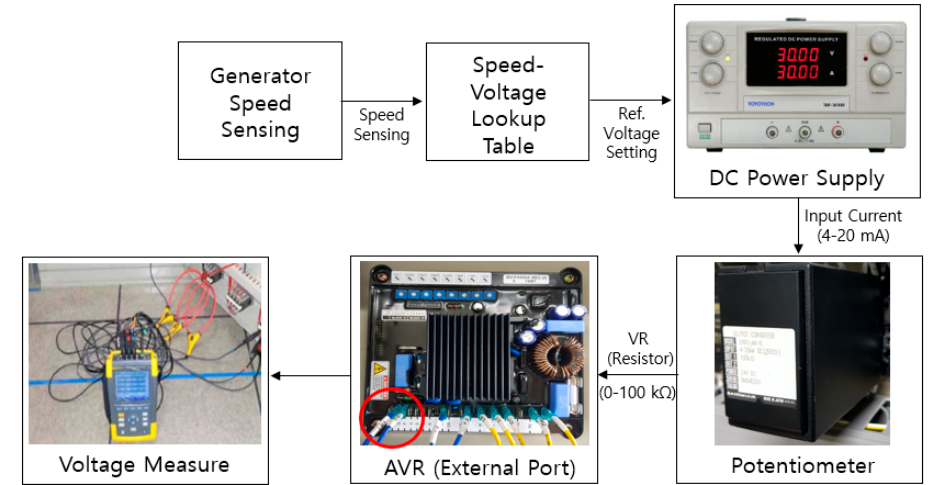
Figure 6. Configuration of input / output data measurement for neural network training.